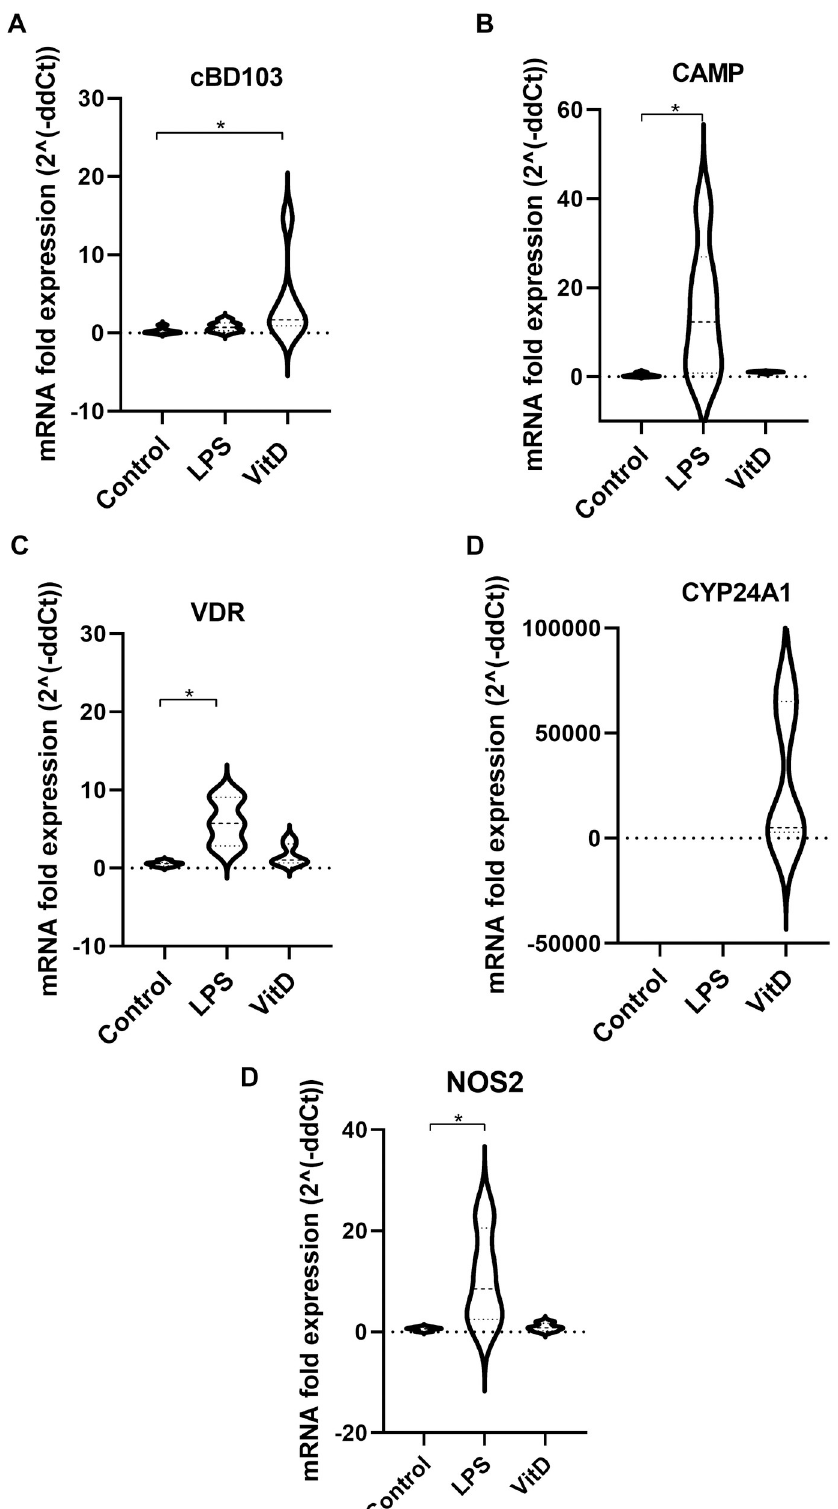
Fig 4. Fold expression of CBD103 (A), CAMP (B), VDR (C), CYP24A1 (D) and NOS2 (E) genes. mRNA fold- increase from VitD treated samples was calculated with reference to its negative control (cells of same extraction but untreated). mRNA expression from 0 condition was normalized from a control with a lowest value ( � P < 0.05). https://doi.org/10.1371/journal.pntd.0009681.g004 PLOS NeglectedTropical Diseases | https://doi.org/10.1371/journal.pntd.0009681 August 16,